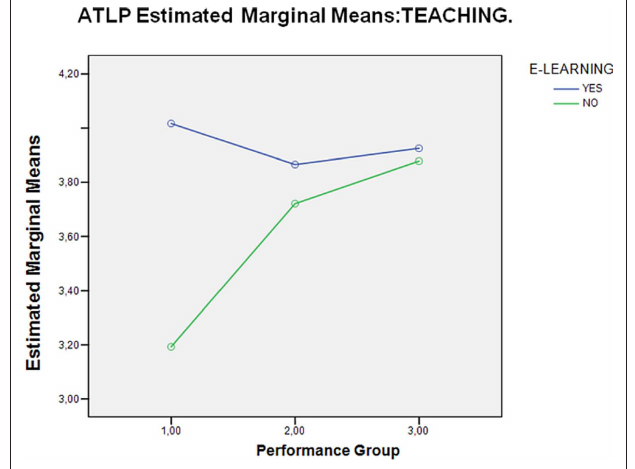
FIguRE 2 | Perception of the teaching process, according to performance level, in class subjects with and without e-learning.